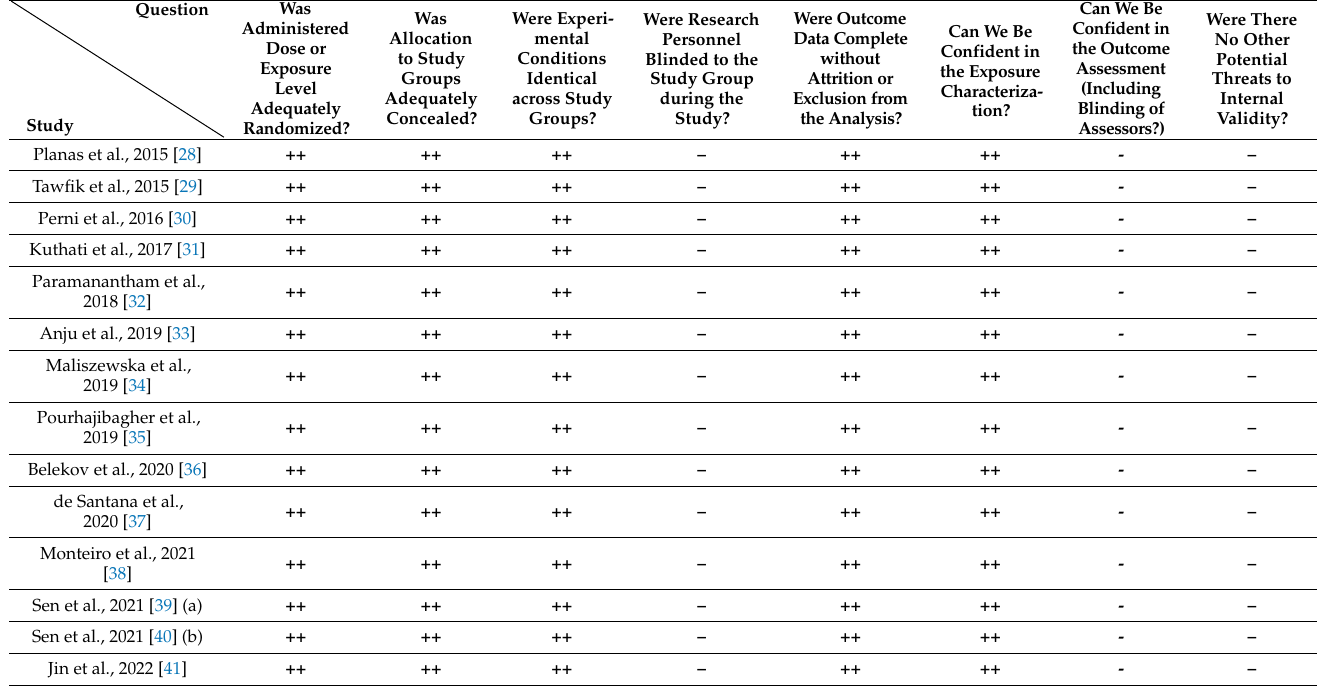
Table 2. Risk of bias assessment according to the OHAT criteria for in vitro